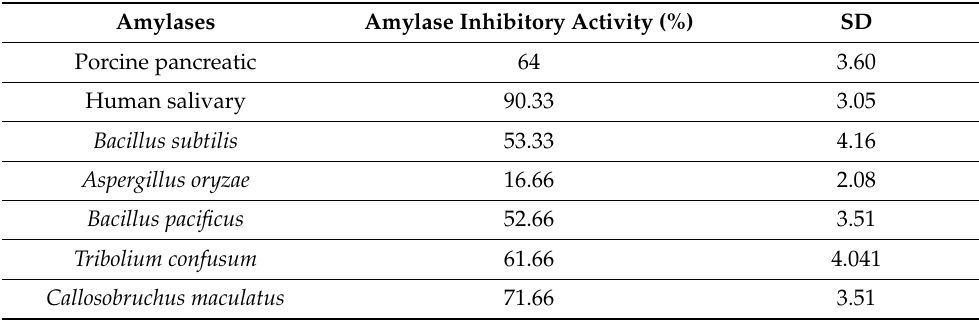
Table 3. Activity of α -amylase inhibitors from Moringa oleifera against mammalian, bacterial, and insect α -amylases.